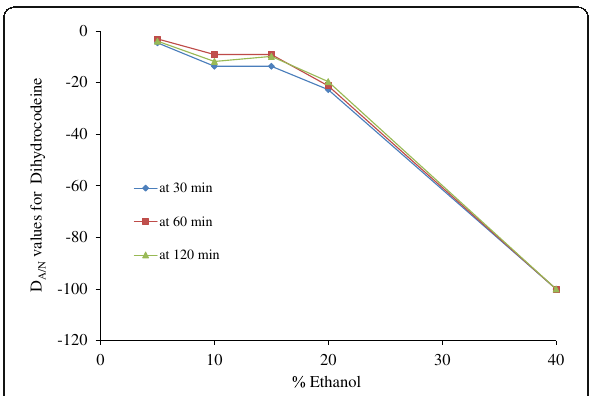
Fig. 6 D A/N value of dihydrocodeine tablets at pH 6.5 phosphate in buffer/ethanol (data from reference (Walden et al. 2007))